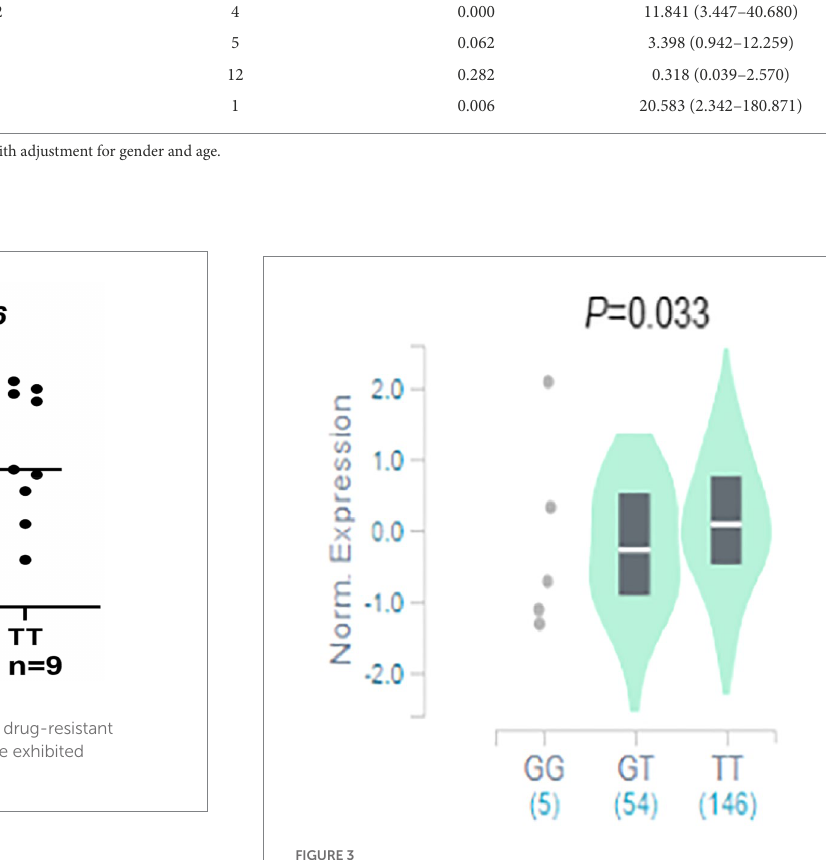
FIGURE 3 The rs2556375 is an eQTL in cortex. Data were retrieved from the brain tissue database GTEx (https://